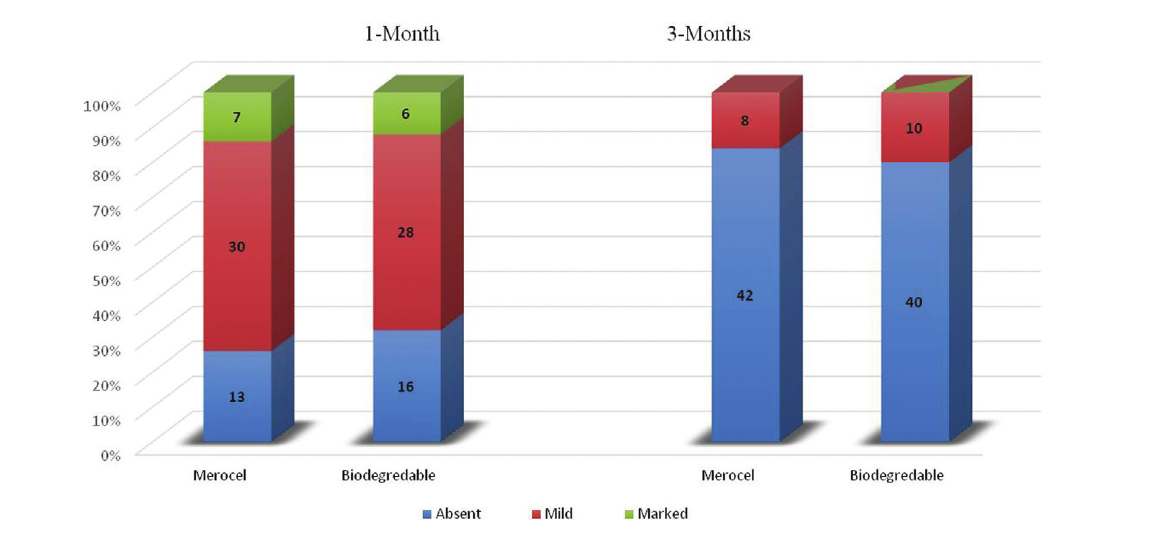
Bar chart illustrating crust formation at 1- and 3-month postoperatively. Figure 6